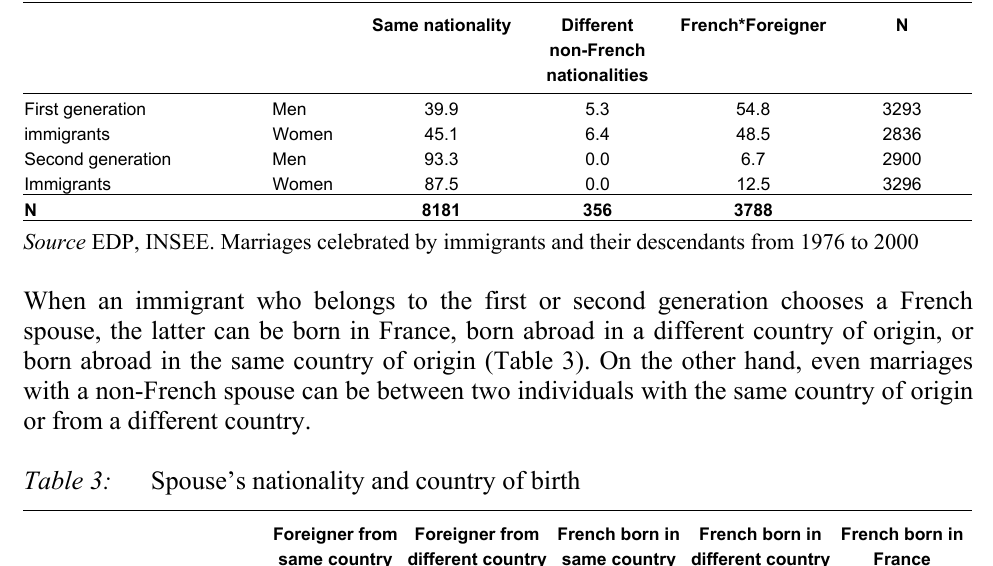
Foreigner from Foreigner from French born in French born in French born in same country different country same country different country